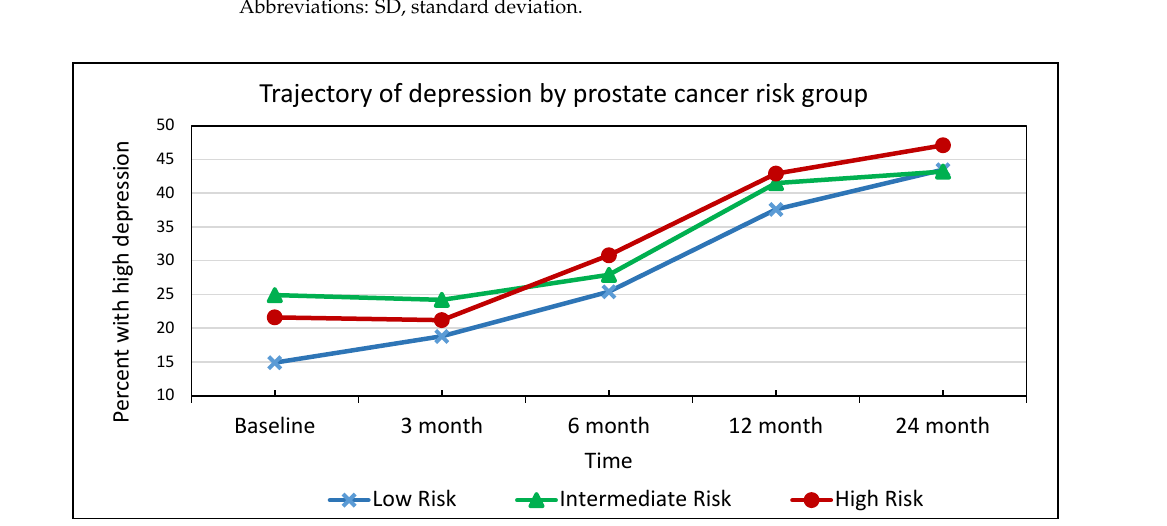
Figure 1. Trajectory of high depression by prostate cancer risk group *. * The increase in the proportion of patients with high depression over time was statistically significant for all three prostate cancer risk groups (0.05 level).